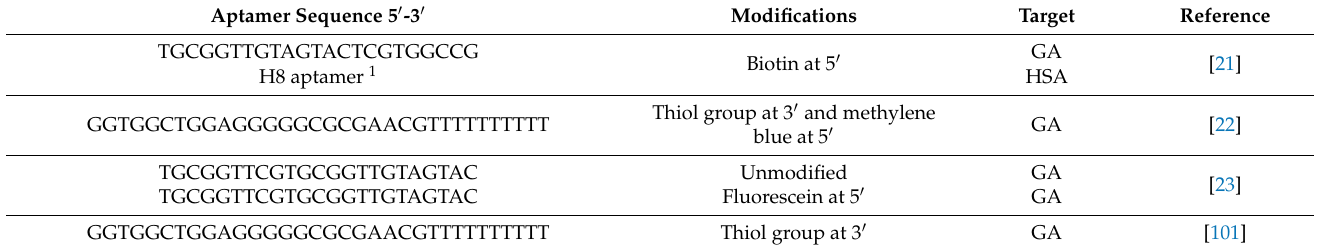
Table 4. Nucleotide sequences of the aptamers adopted in different works to detect GA and/or HSA, with respective modifications and target molecule they are designed to bind to.